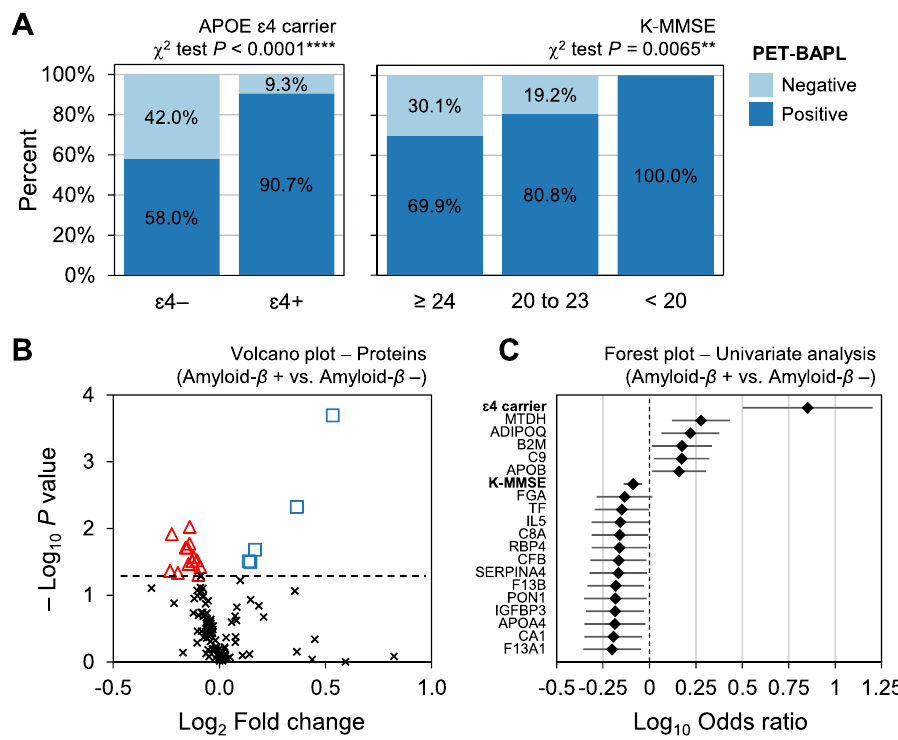
Figure 2. Identification of differentially expressed proteins between PET-BAPL groups. ( a ) PET-BAPL score proportion in APOE ɛ 4 carriers and the K-MMSE group, respectively. ( b ) Volcano plot of differentially expressed proteins between PET-BAPL positive and negative groups. Eighteen proteins, with t -test P values lower than 0.05, are highlighted in red or blue. ( c ) Forest plot of univariate logistic regression analysis of 18 proteins, APOE genotyping results, and K-MMSE